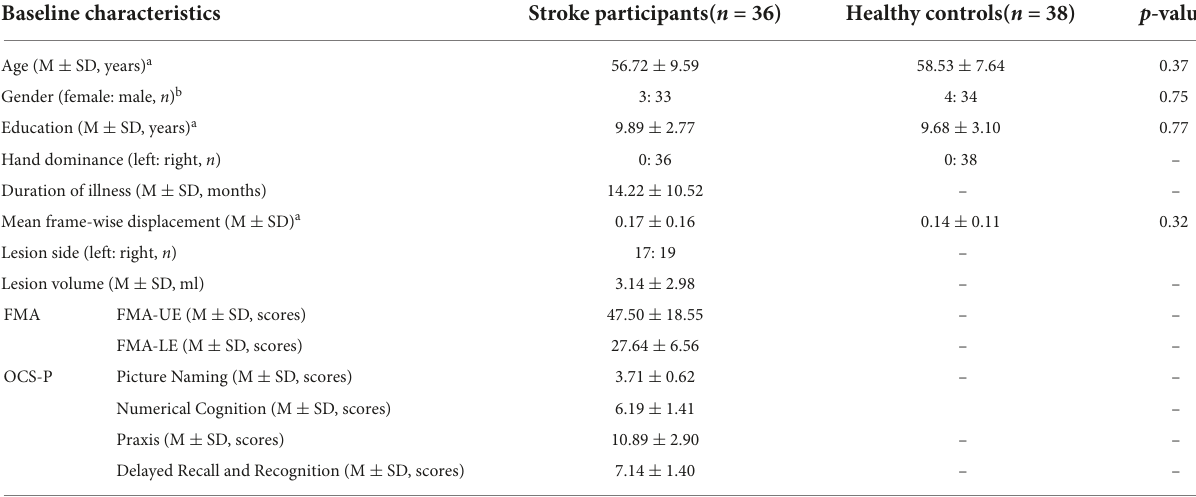
TABLE 1 Demographic characteristics and clinical assessments data of all participants in this